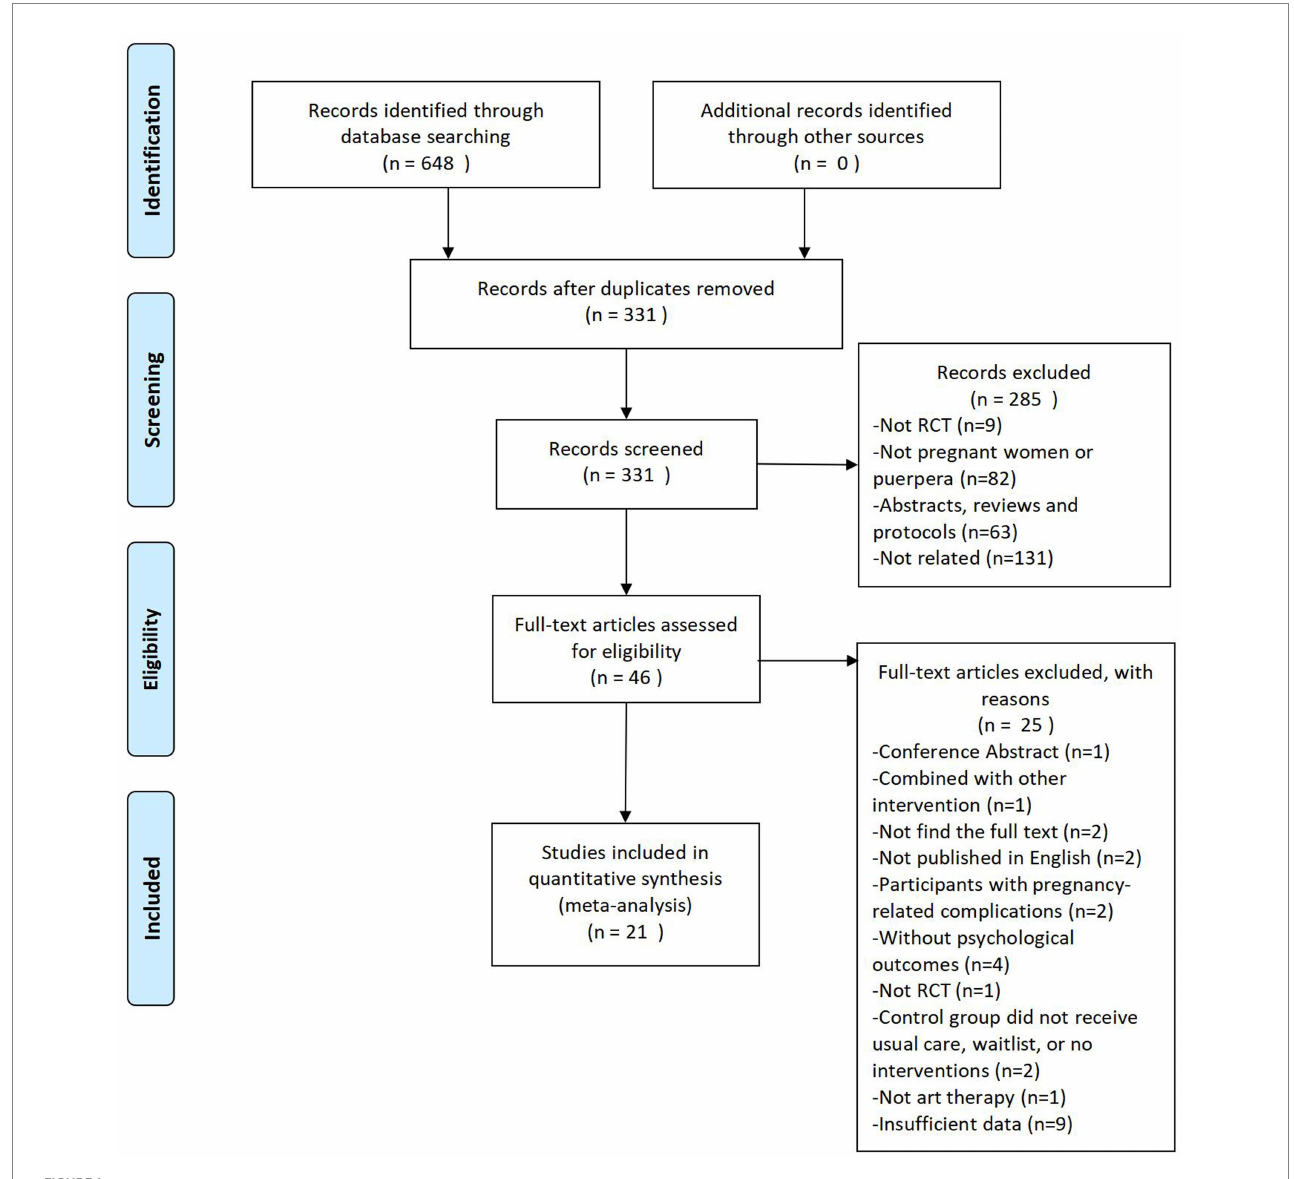
FIGURE 1 PRISMA flow